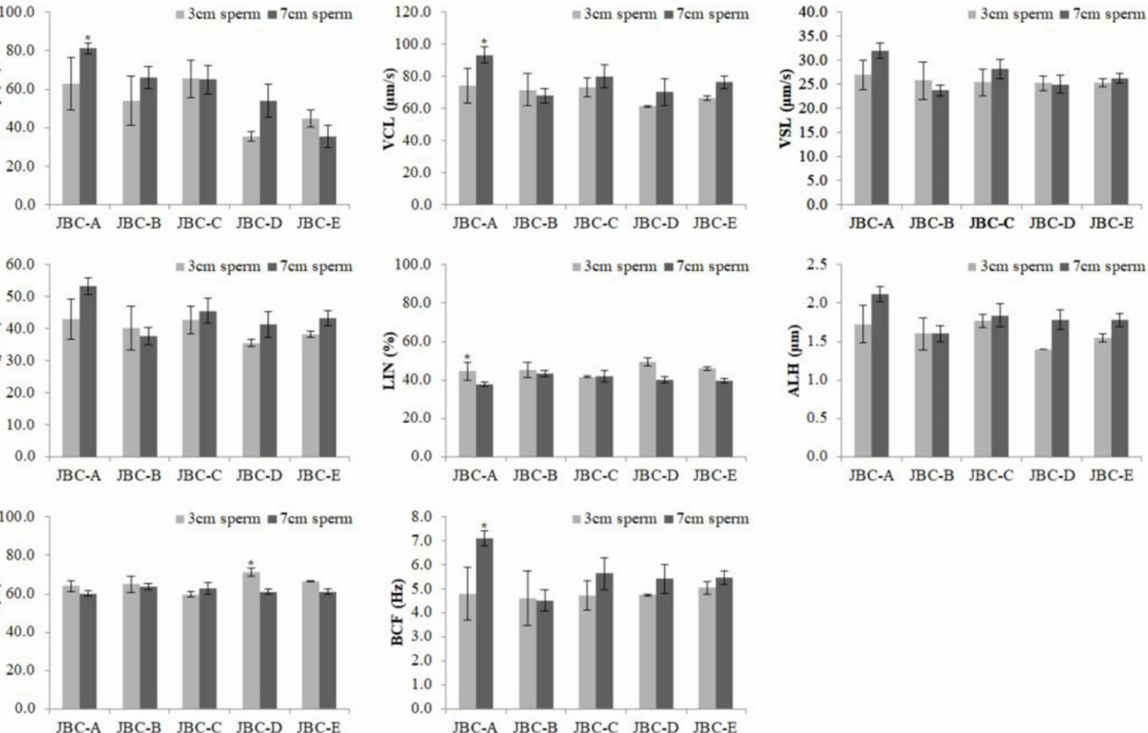
Figure 3. Motility parameters of frozen–thawed 3 and 7 cm sperm from individual Jeju black cattle (JBC) bulls, as evaluated by SAIS. Data shown are the mean ± SEM of three independent replicates per group. * p < 0.05. VCL, curvilinear velocity; VSL, straight-line velocity; VAP, average path velocity; LIN, linearity; ALH, amplitude of lateral head displacement; STR, straightness; BCF, beat cross